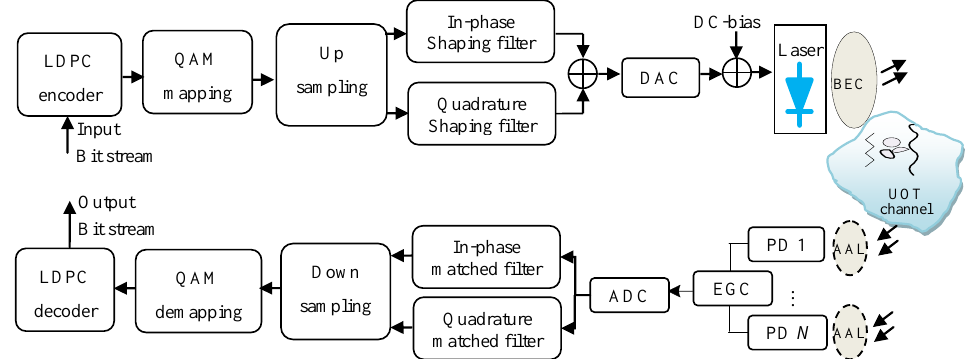
Figure 1. Block diagram of spatial-diversity underwater visible-light communication (UVLC) system employing carrierless amplitude and phase (CAP) modulation scheme and low-density parity-check (LDPC) codes.